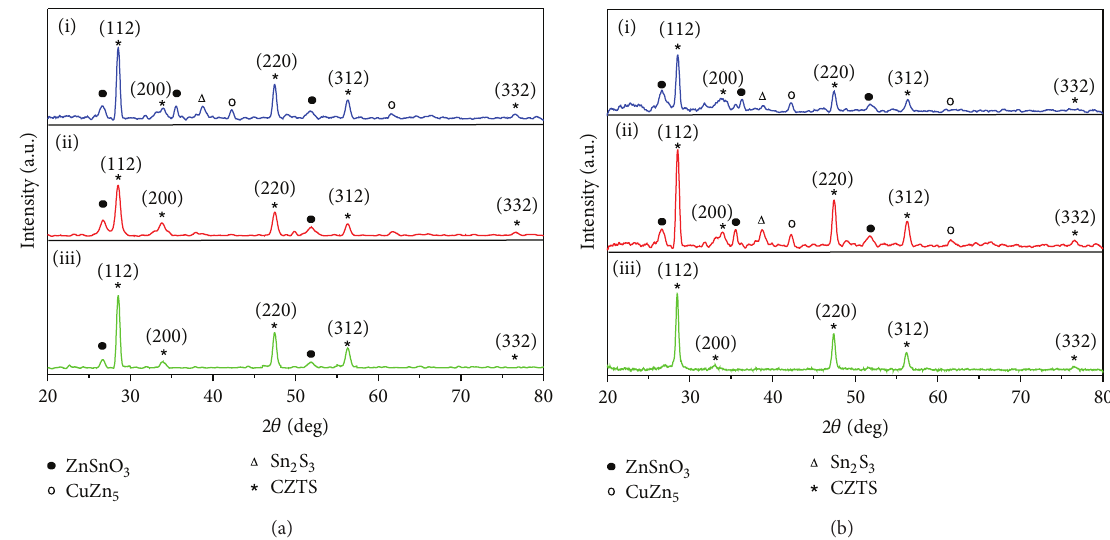
Figure 1: X-ray diffraction patterns of CZTS thin films deposited with target powers (i) Cu:SnS :ZnS:15:80 :100W, (ii)